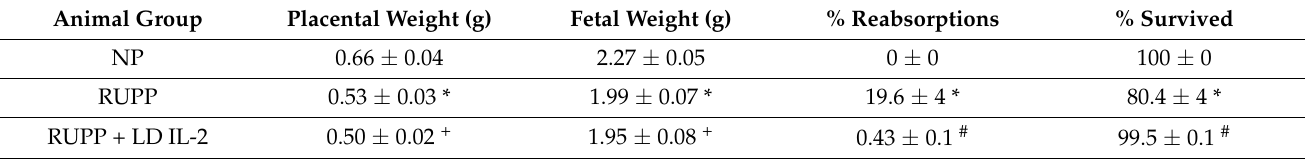
Figure 2. There were increases in the ( A ) placental and ( B ) renal production of mitochondrial ROS in RUPP rats ( n = 5) compared to NP rats ( n = 5). Administration of a low dose IL-2 in RUPP rats ( n = 9) normalized the production of mito- chondrial ROS in the placenta and kidney. Results were reported as means ± SEM and considered statistically significant when p < 0.05. (* p < 0.05 vs. NP control; + p < 0.05 vs. RUPP).